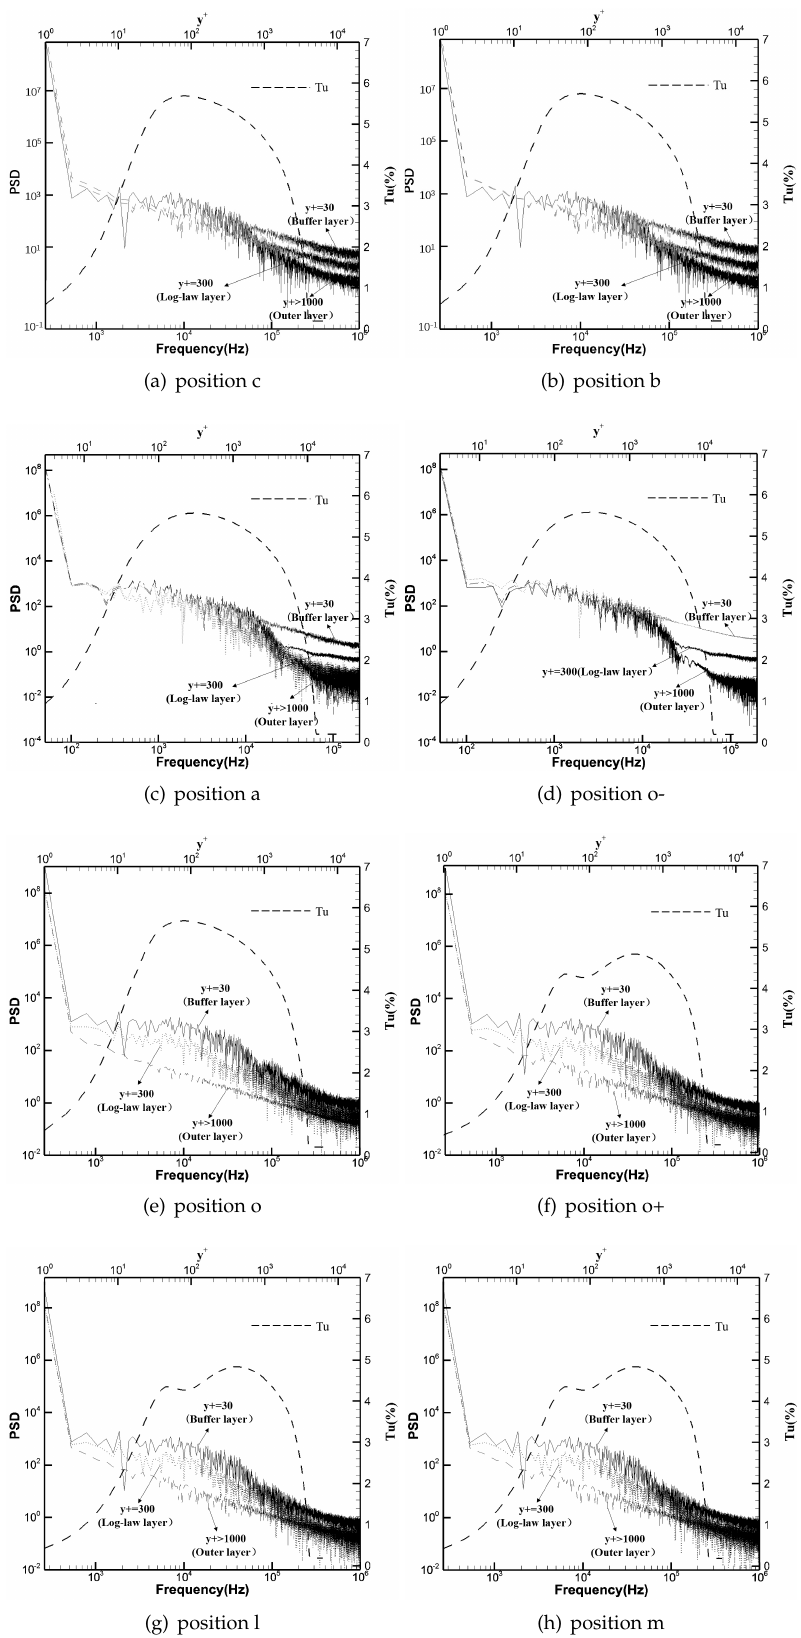
Figure 10. PSD and turbulent intensity at positions